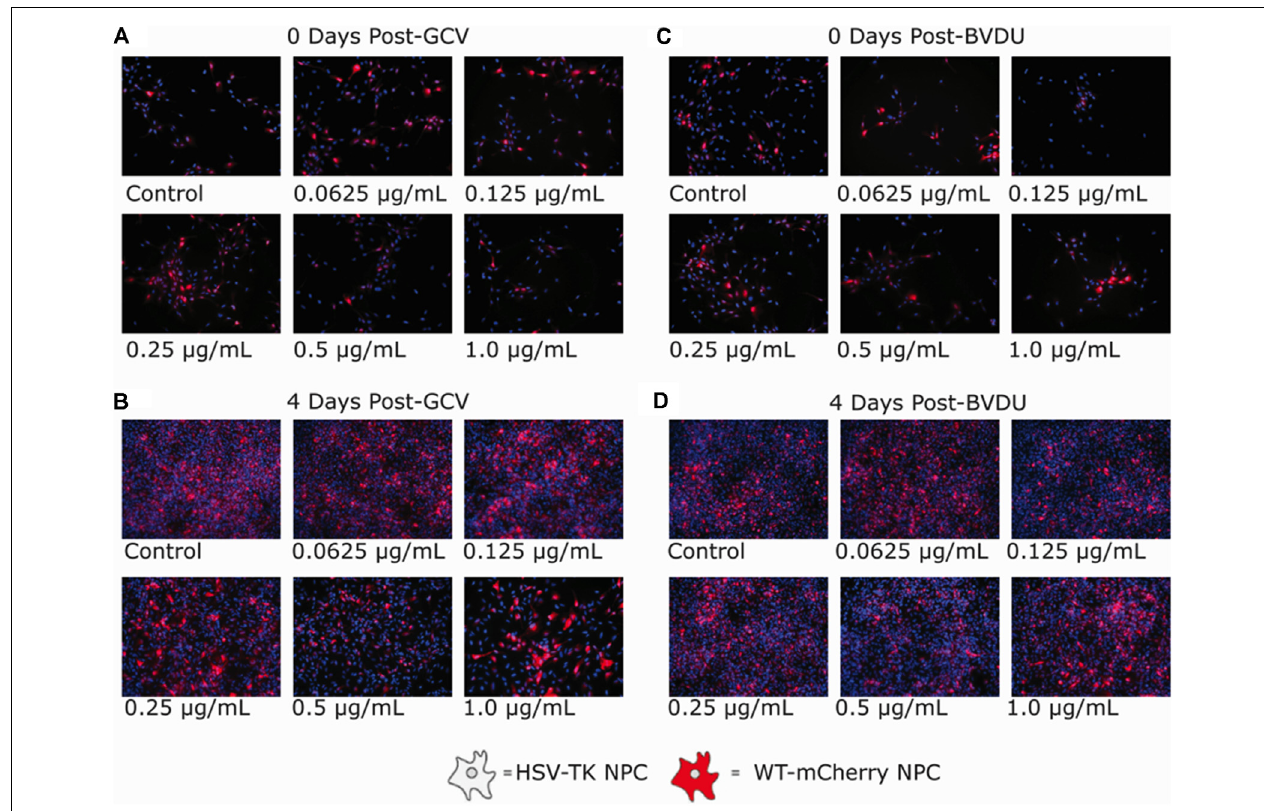
FIGURE 3 | Ganciclovir and brivudine bystander effect assays of HSV-TK + NPCs and WT-mCherry + NPCs. 5.0 × 10 4 cells of a 1:1 mixture of HSV-TK + and WT-mCherry + NPCs were plated in each well of a 6-well plate. Twenty-four hours after plating, cells were treated with 0.0625, 0.125, 0.25, 0.5, and 1.0 µ g/ml of either Ganciclovir or Brivudine (B) and (D) and a negative control (A) and (C) . Ninty-six hours post GCV or BVDU treatment, non-fluorescent spots of DAPI stain are not visible indicating HSV-TK cell death. The mCherry expression is shown in